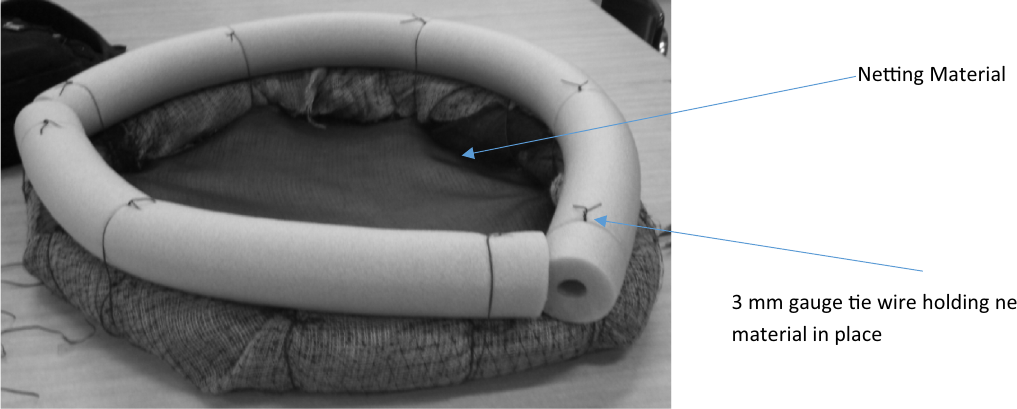
Fig. 2 Example of floating mat prior to planting. The netting material used to retain peat moss is visible on the bottom and center of the floating mat